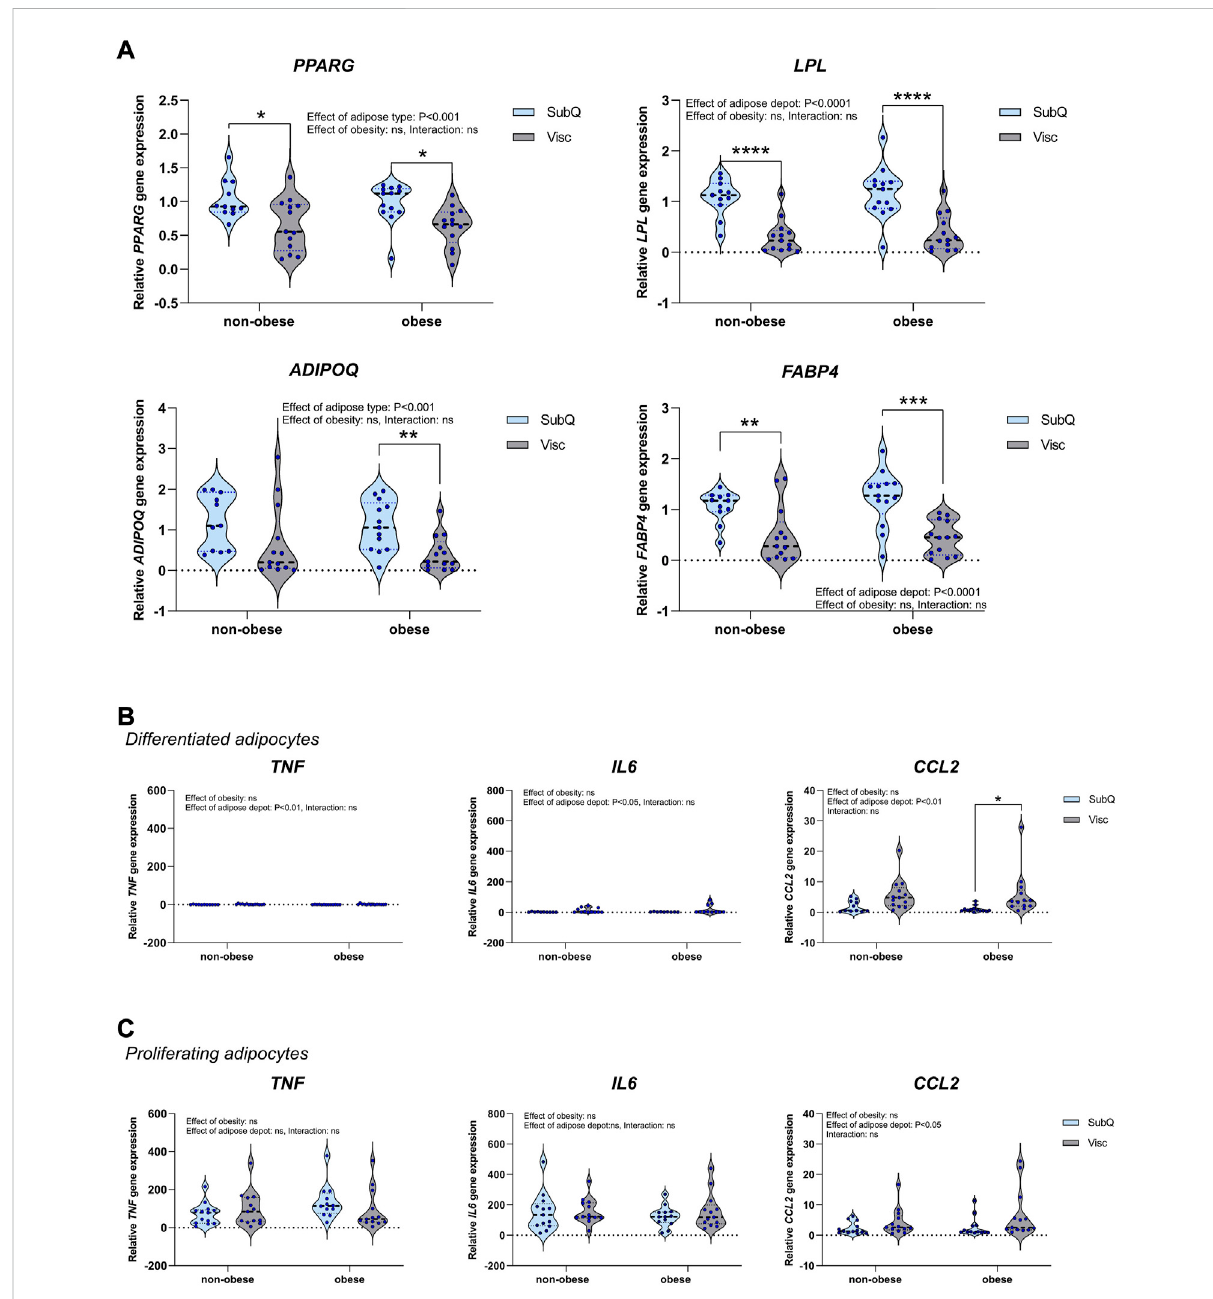
FIGURE 2 Adipogenic and immunogenic gene expression in APSCs from SAT and VAT of non-obese women and women living with obesity. ASPCs were isolated from the subcutaneous and visceral adipose biopsies from women living with obesity ( n = 13) and non-obese women ( n = 13). (A) qPCR analysis was used to measure the relative expression of the adipogenic markers PPARG , LPL , ADIPOQ and FABP4 . QPCR analysis was used to measure the relative expression of the immunogenic markers TNF , IL6 and CCL2 in (B) Differentiated adipocytes and (C) Proliferating APSCs. Dataarepresentedasviolinplotswiththickdottedlineshowingmedianandthindottedlinesshowingquartiles. Two-wayanovaassesseddifference between groups and depots. Results from signi fi cant post-tests are shown as: * p < 0.05, ** p < 0.01, *** p < 0.001, **** p <